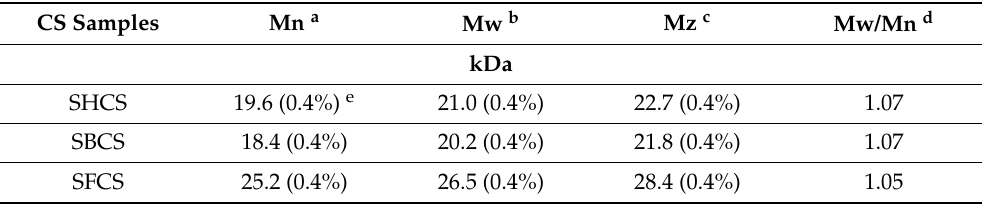
Figure 2. Analysis of Chinese sturgeon cartilage CSs by PAGE. The CS preparations from head, backbone, and fin cartilages of Chinese sturgeon were analyzed and compared with commercial CSs by PAGE using 18.3% polyacrylamide gels followed by staining with Alcian Blue, as described under “Section 2”. Lane A: CS-A; Lane B: CS-C; Lane C: CS-D; Lane D: SHCS; Lane E: SBCS; Lane F: SFCS. Table 2. The Molecular Weight of CS Preparations from Chinese Sturgeon Cartilage. The values in the brackets correspond to the